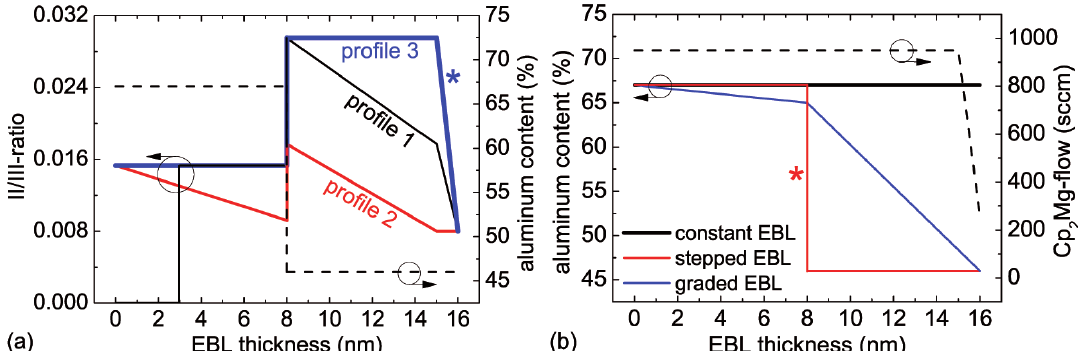
Figure 1. Illustration of the different EBL designs: ( a ) temporal Cp 2 Mg carrier gas flow profiles (sample series 1) and ( b ) aluminum composition profiles (sample series 2). The curves in ( a , b ) corresponding to the same EBL design are marked by a